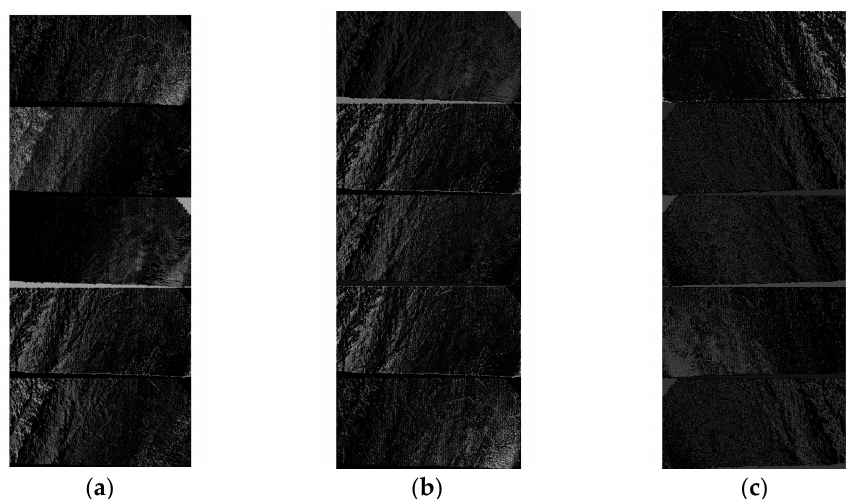
Figure 7. Feature extraction results for each layer in S1. ( a – c ) show results from the first to the third layer.